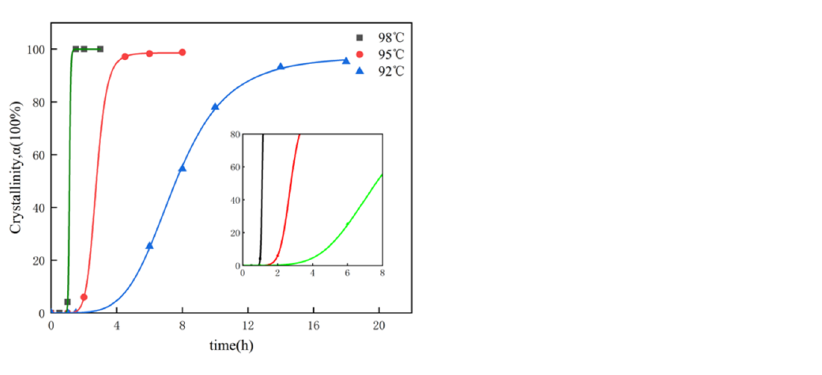
Figure 2. Crystallization curves for α -HH samples synthesized through the hydrothermal process at various temperatures.